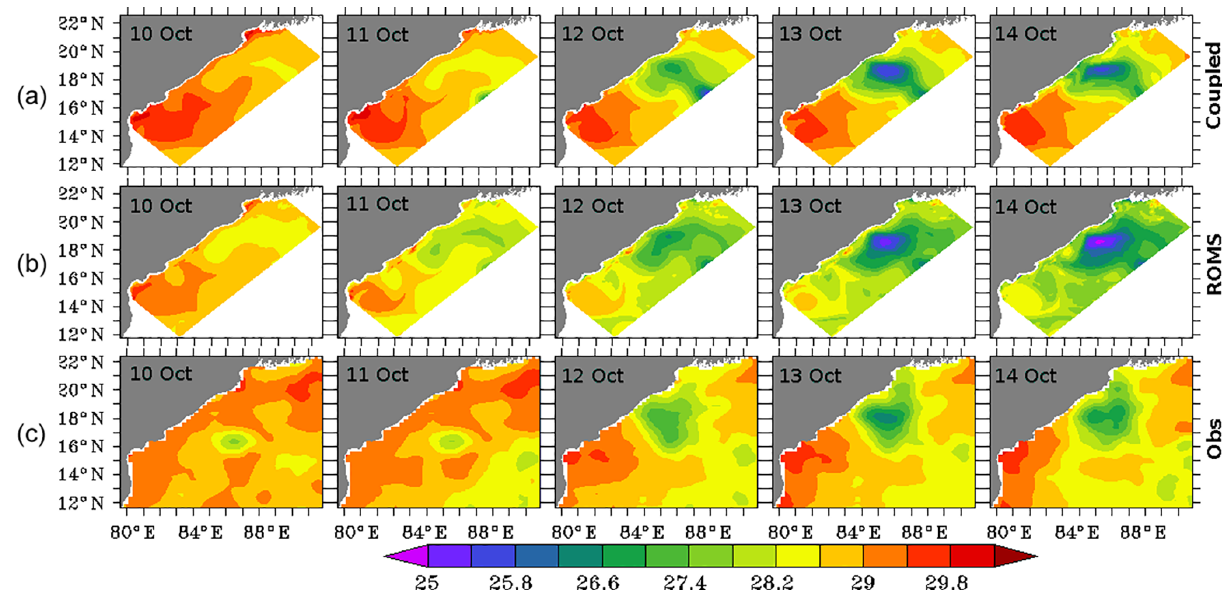
Figure 5. The daily averaged sea surface temperature (SST) in ◦ C simulated by the coupled model (a) and stand-alone ROMS model (b) and observed from AVHRR sensor on the satellite (c)